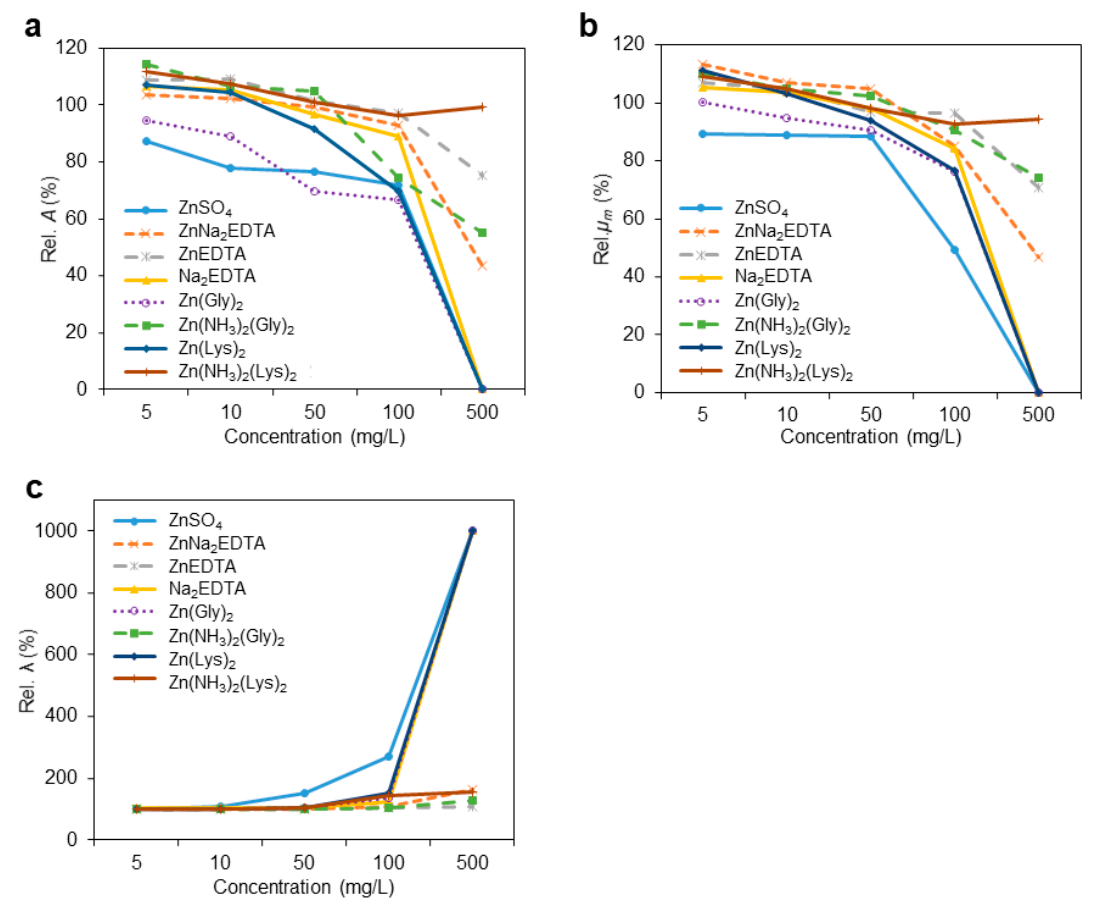
Figure 3. Effect of increasing doses of test compounds on the growth parameters of B. subtilis ( a ) relative maximal growth (Rel. A ), ( b ) relative growth rate (Rel. μ m ), and ( c ) relative lag phase (Rel. λ ). The growth parameters are shown relative to the test-compound-free B. subtilis growth parameters. When no growth was observed, A and μ m were considered to be 0, while λ , the lag phase, was considered to be the duration of the experiment, 24 h.